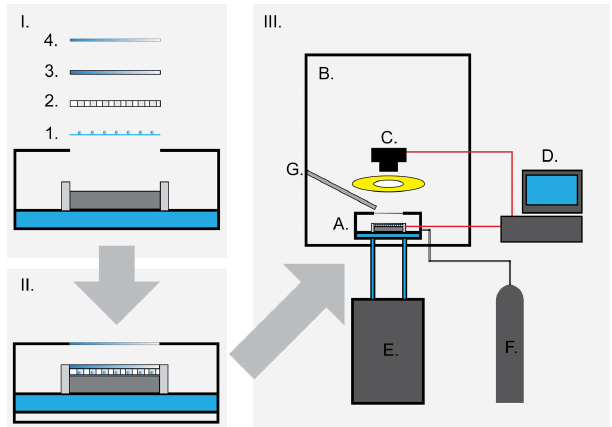
Figure 2. The Lund University Cold-Stage (LUCS). (I) The freez- ing array design. The sample is placed on siliconized hydrophobic glass substrates (1) which are placed on the cold stage. The sam- ple drops are separated by a silicone grid (2) confining each drop to an individual cell, between the glass substrate and a polycarbonate lid (3). The freezing array is in turn encased in a small environ- mental chamber, with a quartz viewing window (4). (II) The sam- ple mounted in the assembled freezing array. (III) Overview of the LUCS system. The cold stage (A) is placed in a laminar airflow cabinet (B) to avoid any possible contamination. A camera system with a circular continuous LED light source is fixed above the cold stage’s viewing window and focused on the cold stage. The cam- era is controlled by a computer (D), and a cryogenic water circula- tor (E) provides the cold stage with 8.5 ◦ C cooling water, acting as a heat sink for the device. The environmental chamber is continu- ously purged with dry nitrogen gas, and a flow of dry, HEPA-filtered air (G) is directed at the viewing window to eliminate potential fog- ging at low